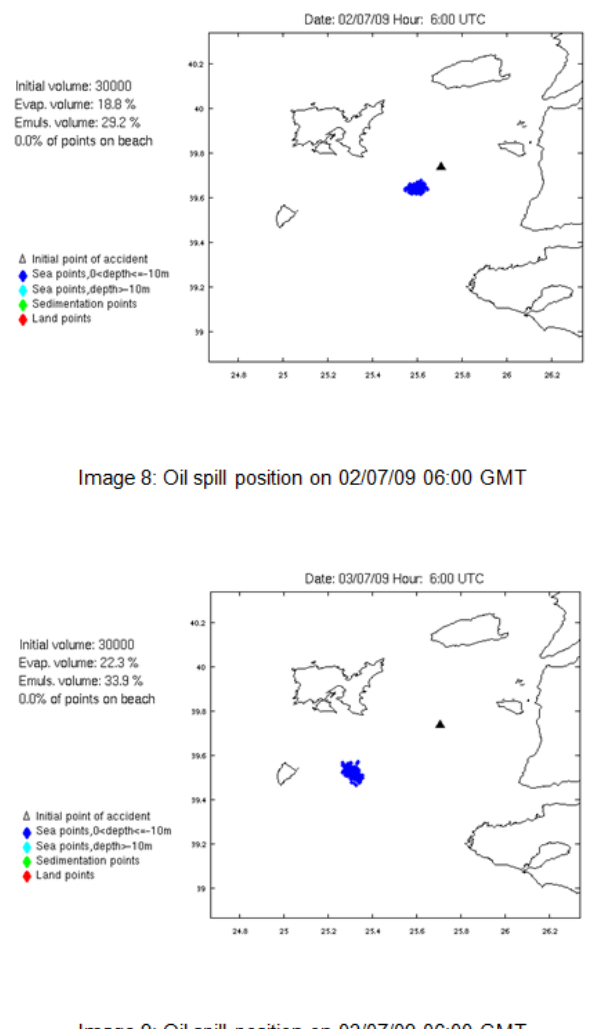
Figure 6: Sample of the common output file produced by the oil spill model. Fig. 6. Sample of the common output file produced by the oil spill model. Fig. 7. Sample of the oil spill evolution forecast related to the accident of 27 June 2009 as it sent to the Greek